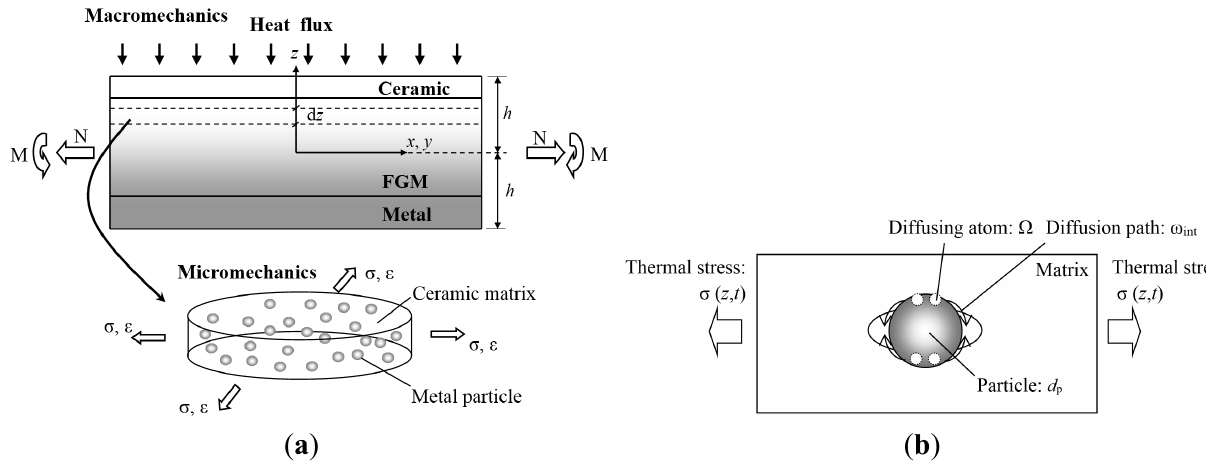
Figure 1. Schematic illustration of ( a ) a functionally graded thermal barrier coatings (FG TBCs) subjected to thermo-mechanical loadings and its building block of the thin layer composed of spherical particle-dispersed composites, and ( b ) mass transfer at the particle/matrix